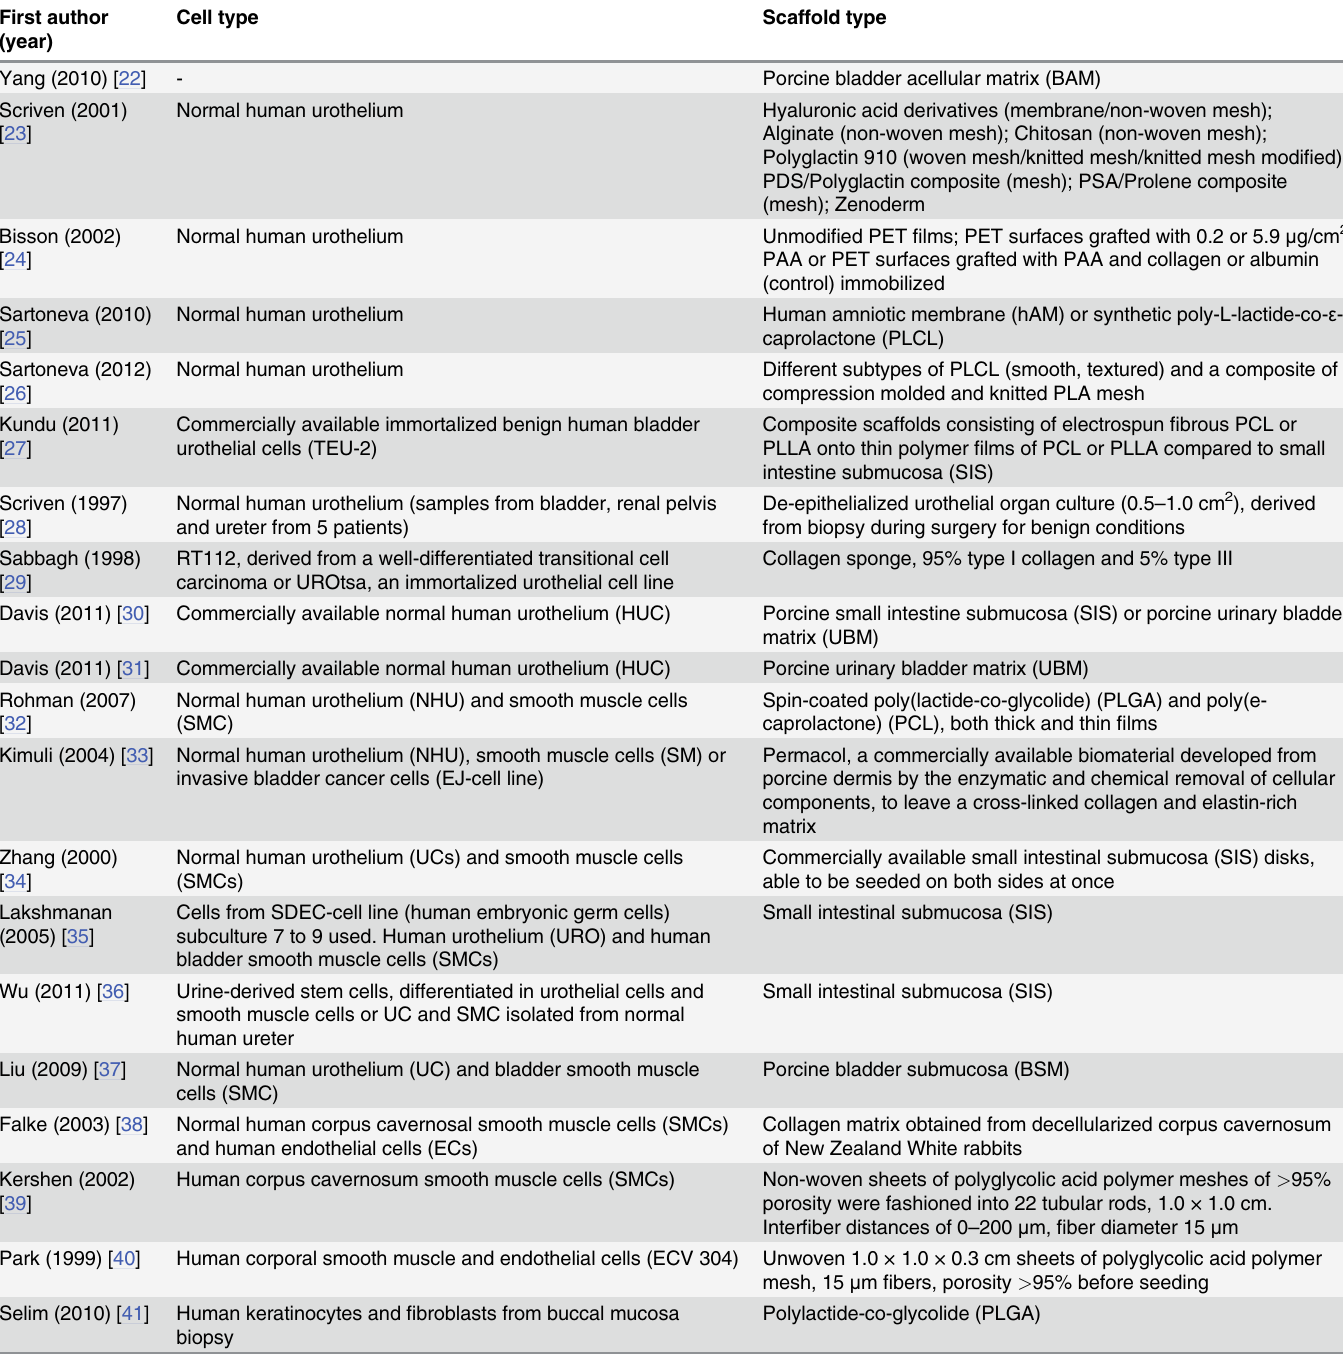
Table 2. Studies investigating scaffolds and cell-seeded scaffolds (n =